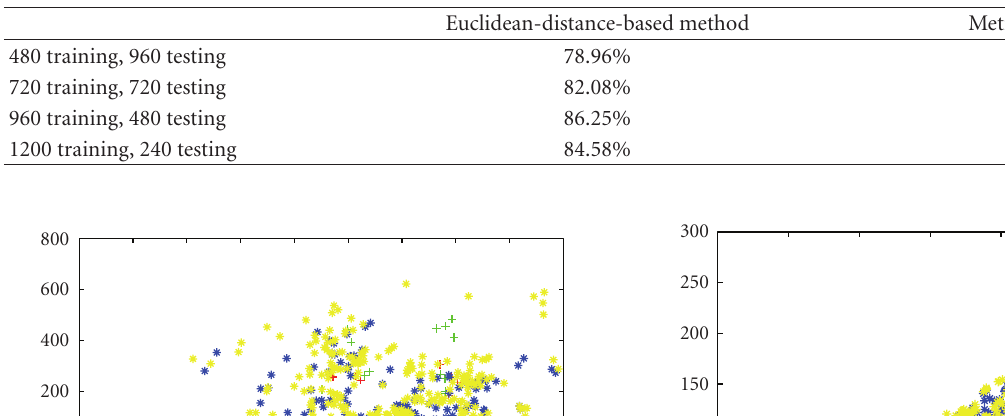
Table 2: The recognition rates of the compared methods.